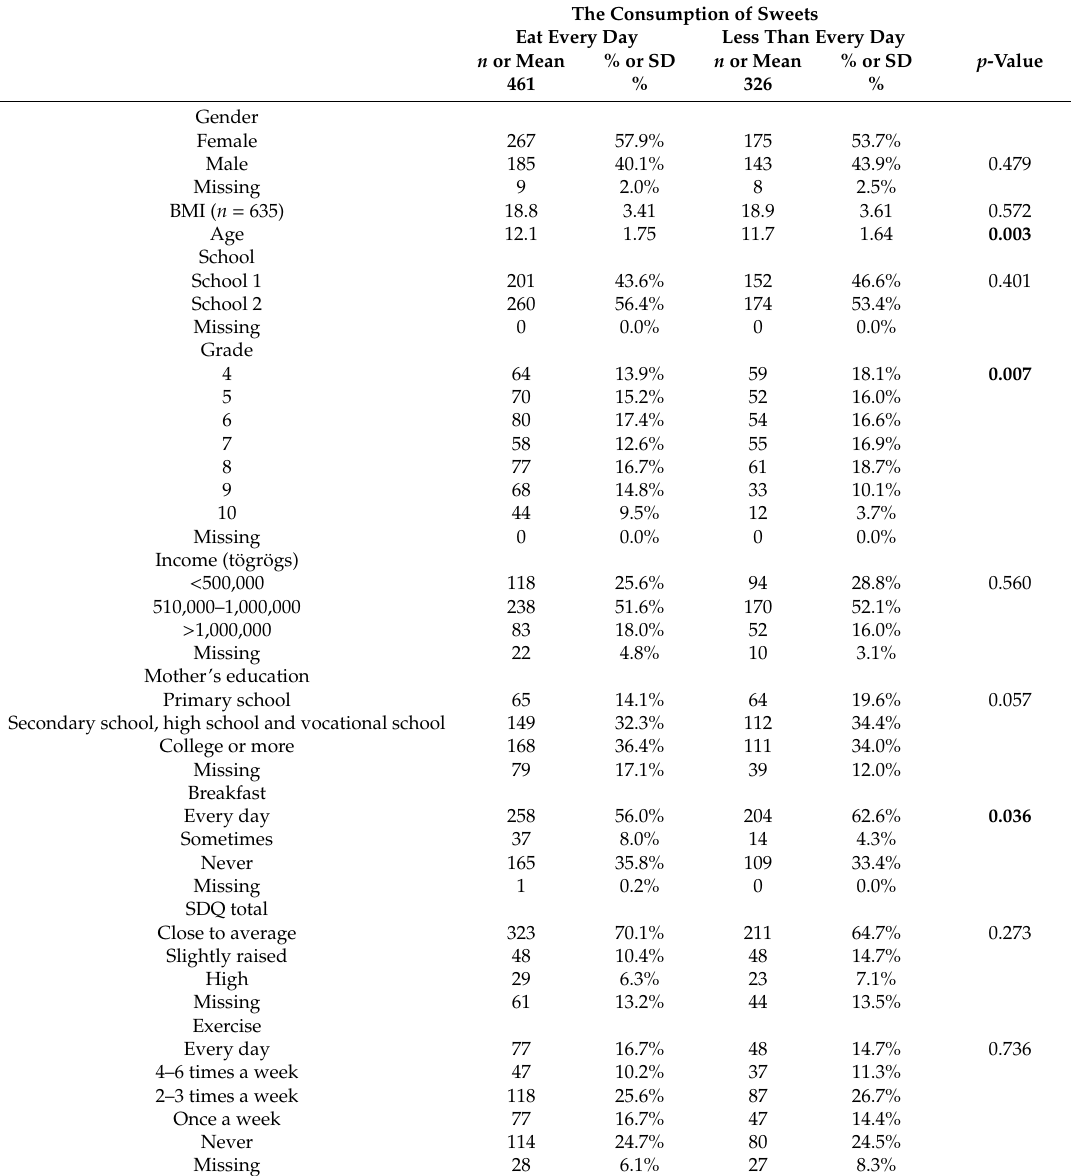
Table 1. Study population characteristics ( n =